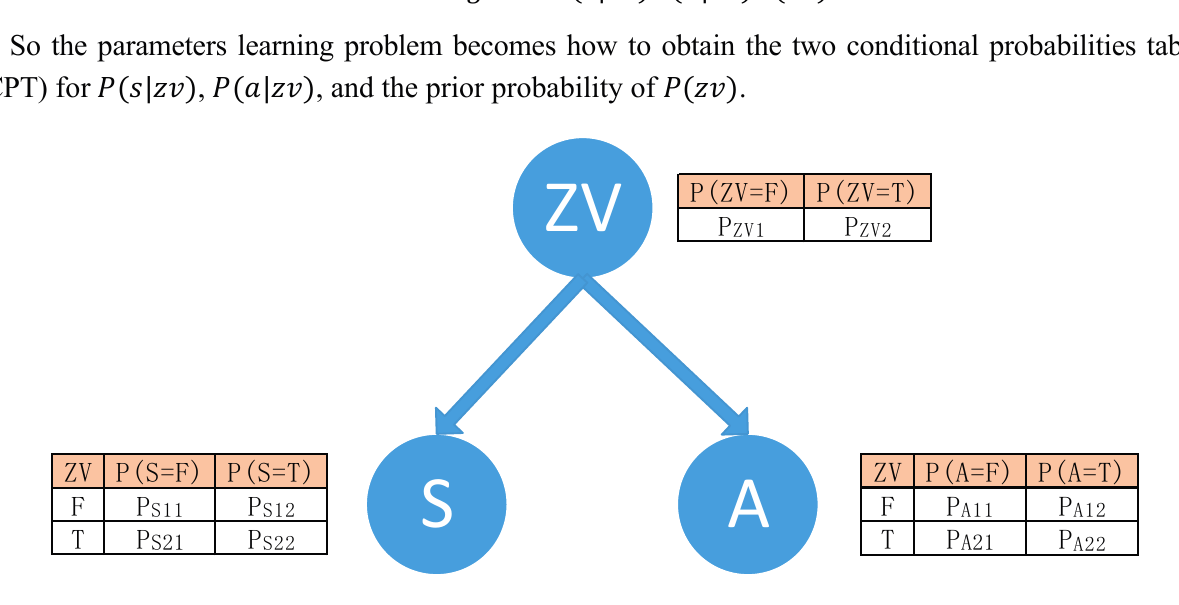
Figure 6. Bayes-based model of the ZV